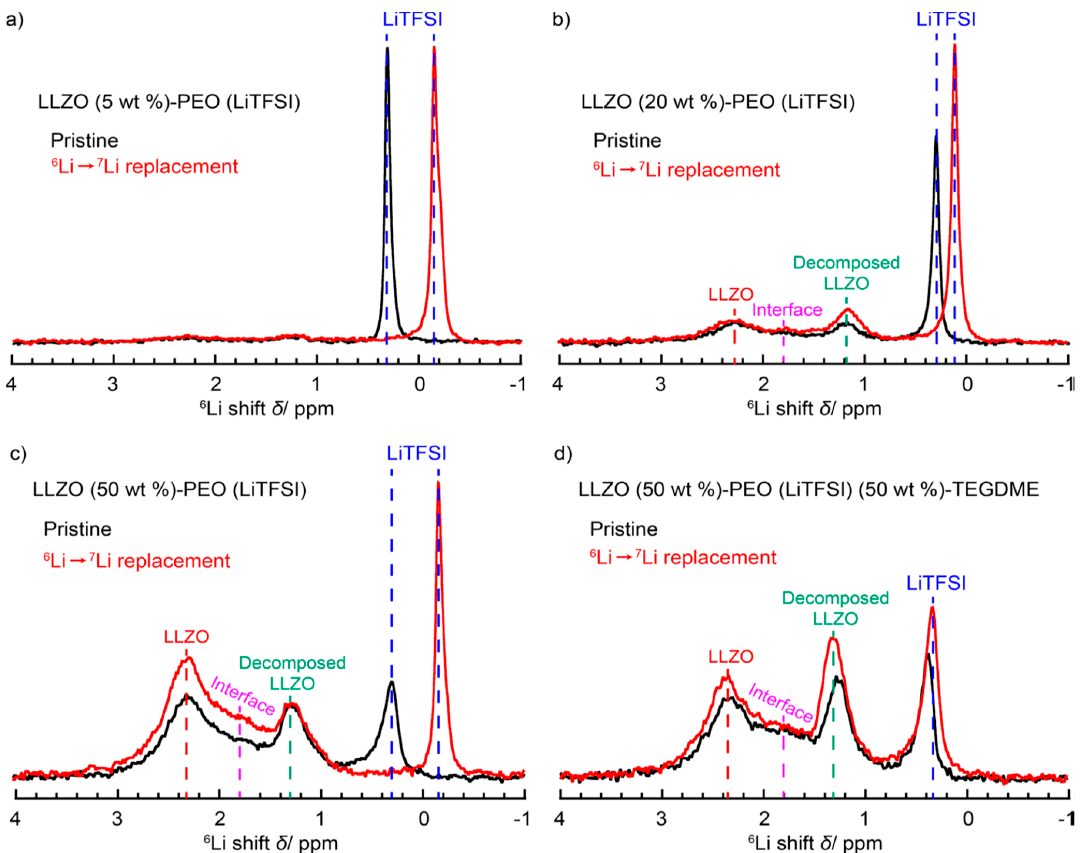
Figure 1. 6 Li NMR comparison of pristine and cycled LLZO (5 wt. %)-PEO (LiTFSI), LLZO (20 wt. %)- PEO (LiTFSI), LLZO (50 wt. %)-PEO (LiTFSI), and LLZO (50 wt. %)-PEO (LiTFSI) (50 wt. %)-TEGDME [50]. Reprinted with permission from [50]. Copyright 2018 American Chemical Society.